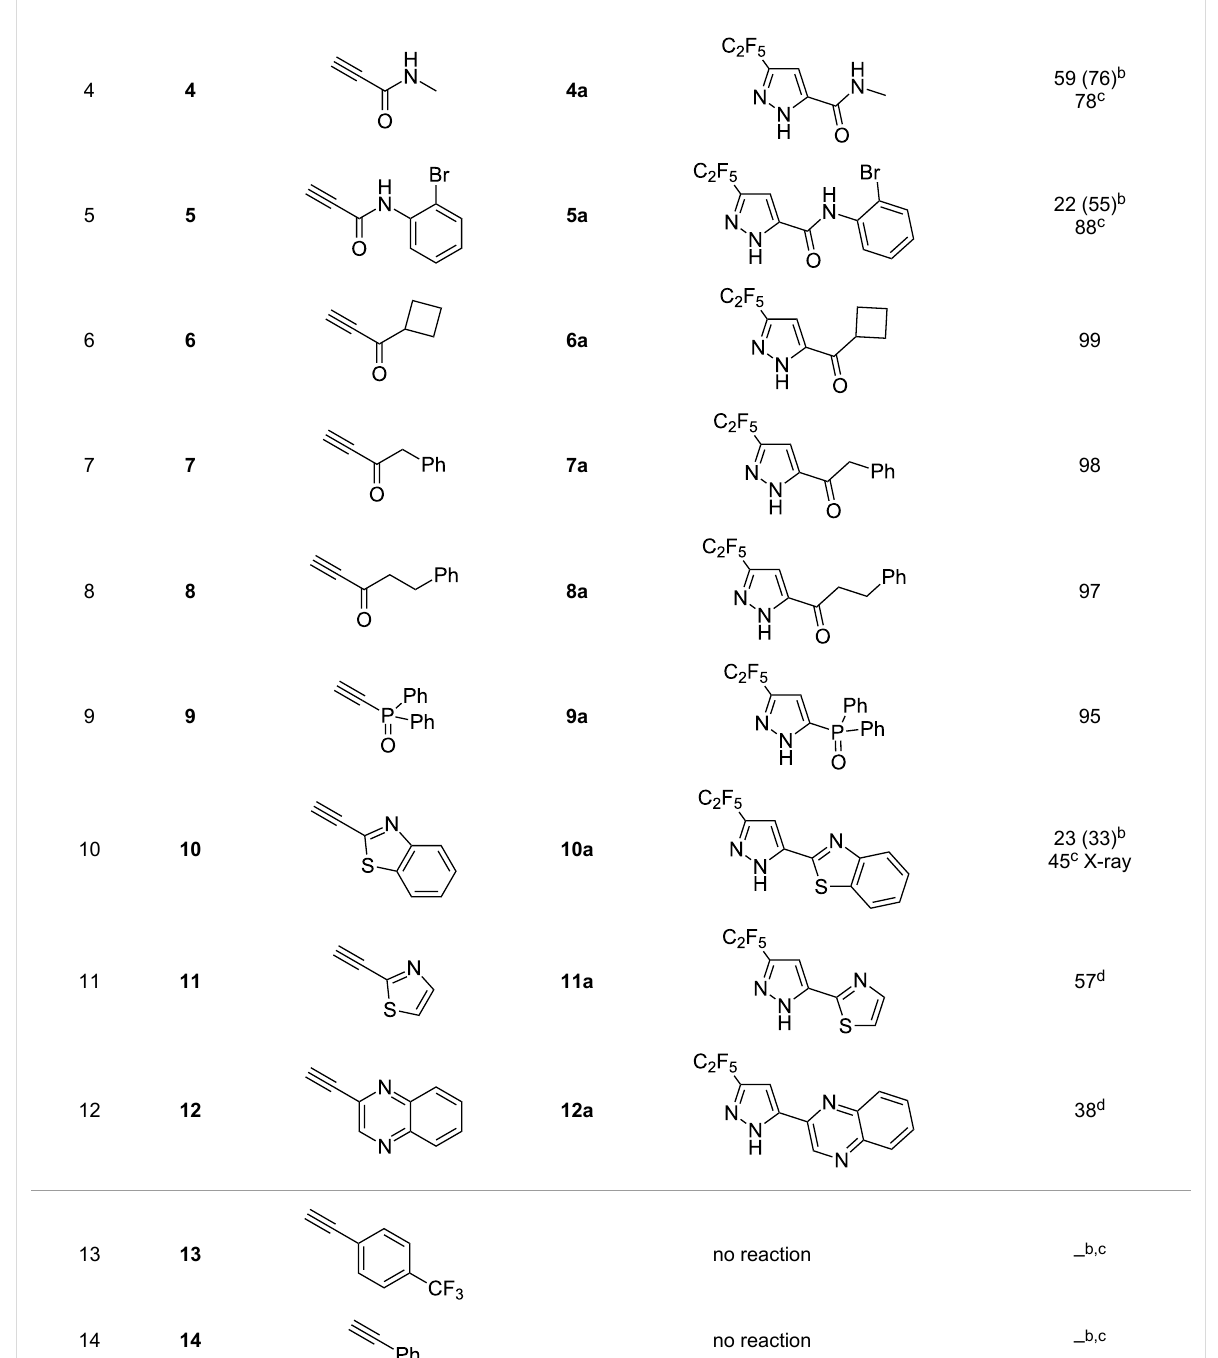
Table 2: Synthesis of C 2 F 5 -substituted pyrazoles from mono-substituted alkynes.